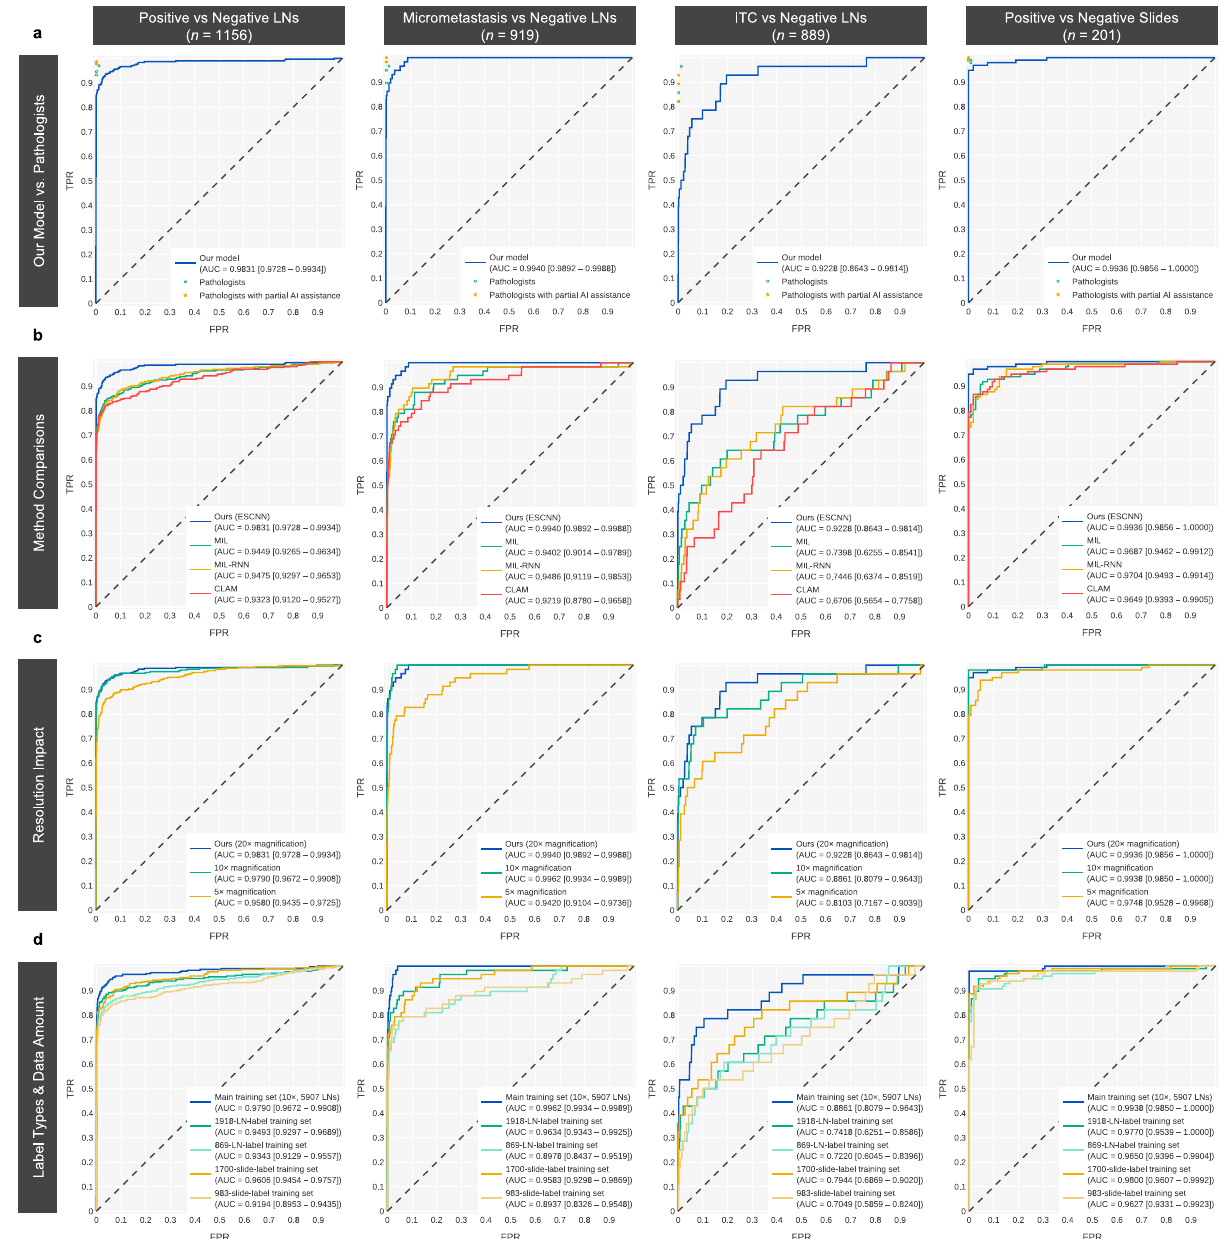
Fig. 2 Receiver operating characteristic (ROC) curves of the metastasis identi fi cation ability of the models under the main test set of 1156 LN images. The rows present a comparison of ( a ) the performance of our model with those of three pathologists before and after receiving AI assistance on the 48 equivocal cases; ( b ) weakly supervised methods; ( c ) performance obtained under various magni fi cation levels (20×: 0.46 µ m/pixel, 10×: 0.92 µ m/pixel, 5×: 1.84 µ m/pixel); and ( d ) performance obtained under different label types and amounts of training data. We evaluated each method with the main test set and its subsets to retrieve the ROC curves. The fi rst column presents the ROC curves differentiating between the 1156 LNs in the main test set. Among the 1156 LNs, those marked as micrometastases and ITCs, as well as all the negative LNs, were sampled to evaluate the performance of the model in identifying micrometastases and ITCs, as presented in the second and third columns. The fourth column displays the slide-level